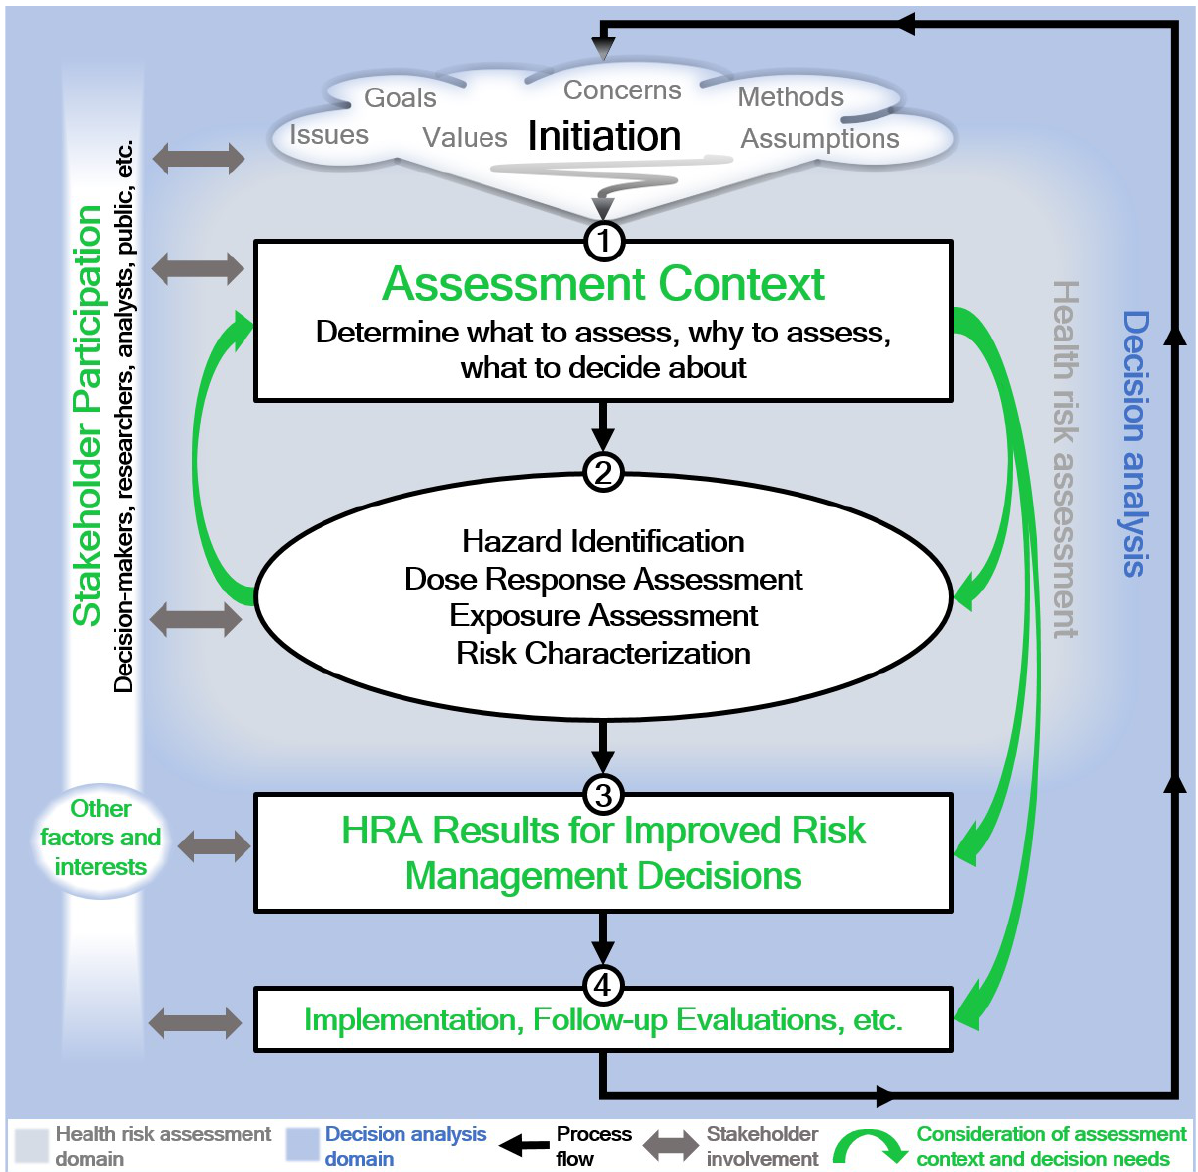
Figure 2. Opportunities for improving the utility of HRA.